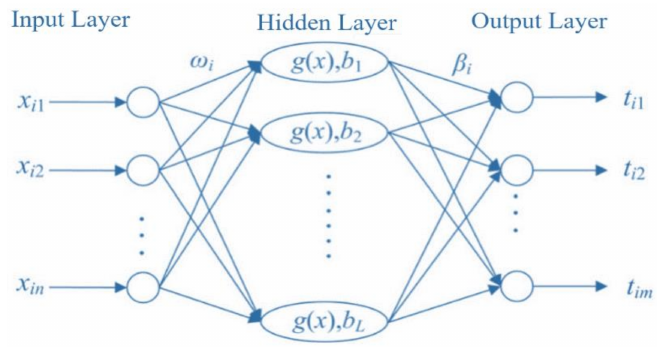
Figure 2. The structure of